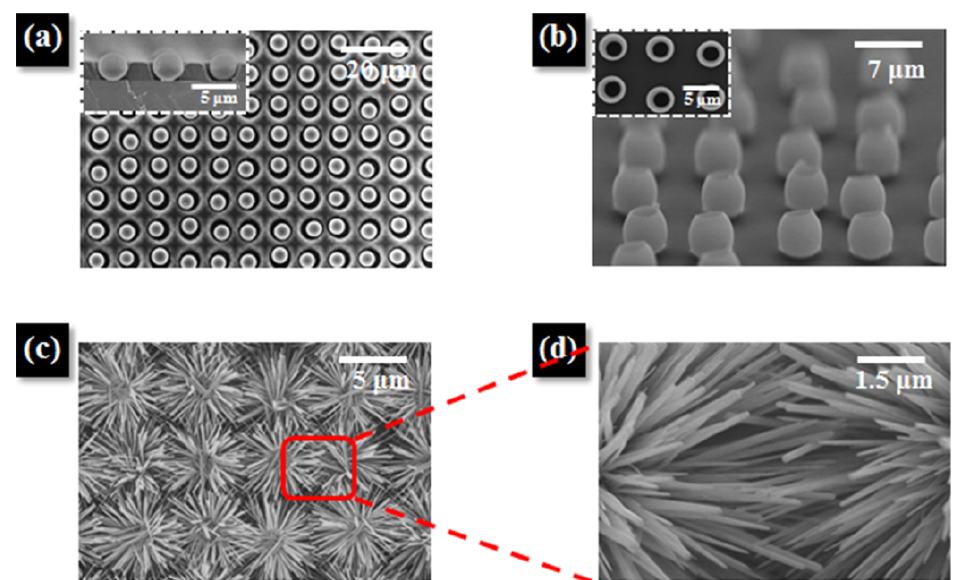
Figure 10. ( a ) Top-view SEM image of a microparticle array in circular well patterns. Inset: Cross- sectional SEM image showing microparticles arrayed in height-optimized well patterns. ( b ) Tilted- view SEM image of aligned ZnO shells after transfer and calcination at 250 °C for 3 h in air on a hot plate. Inset: Top-view SEM image showing polystyrene-removed ZnO shells after calcination. ( c ) SEM image of the ZnO nanoflower network structure after growth of ZnO NRs in- and outside the shells, and ( d ) magnified SEM image of the junctions between the NRs. Reprinted with permission from Ref. [96]. Copyright 2017 American Chemical Society.